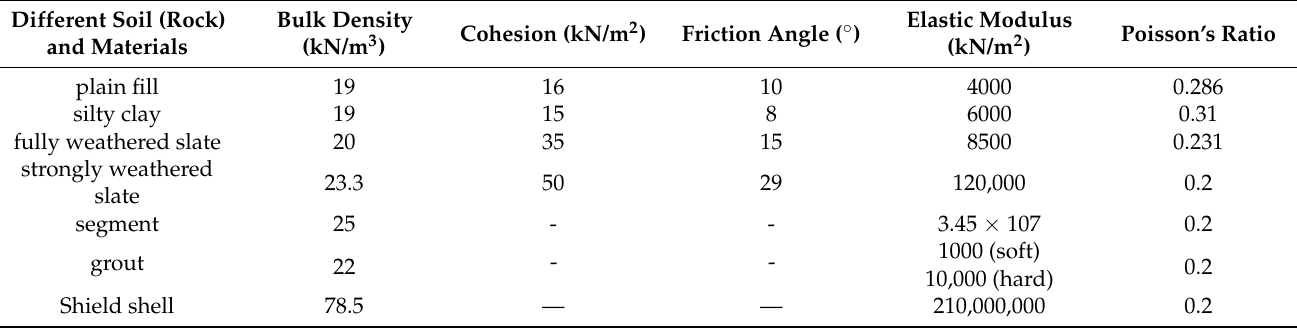
Table 1. Physical parameters of each